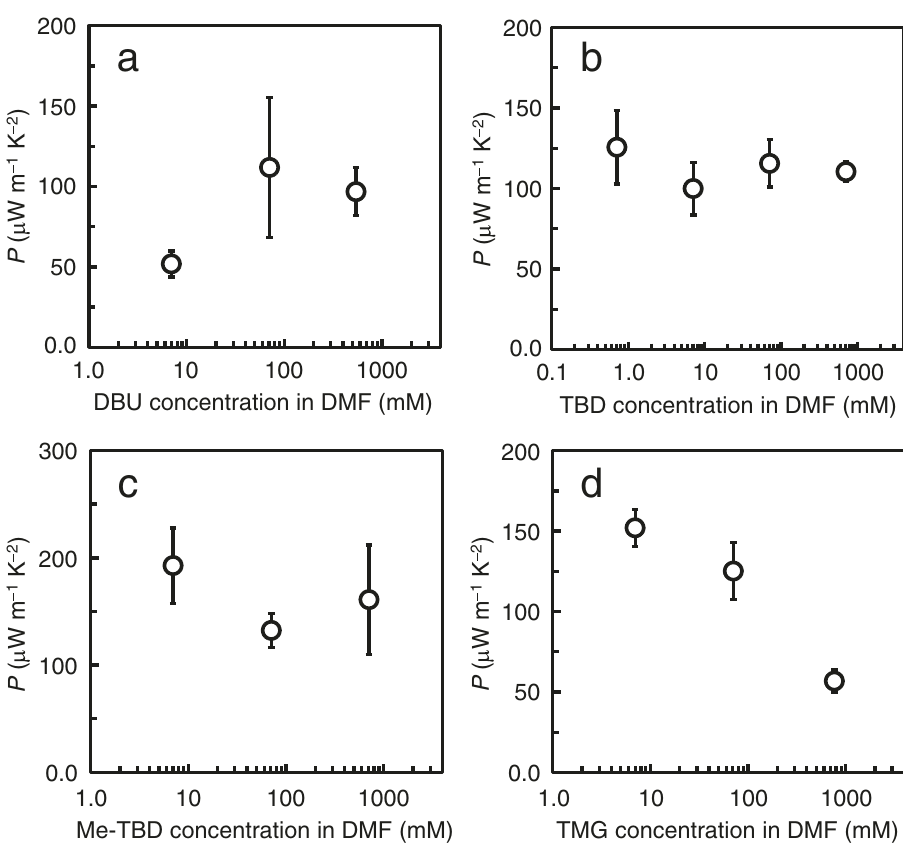
Fig. 7 Dopant-concentration-dependent Power factor ( P ). n-Type specimens were prepared by immersing EC1.5-CNT fi lms in DMF solutions of a DBU, b TBD, c Me-TBD, d TMG with varied concentrations. Data statistics: n ≥ 3. Error bars indicate the corresponding SDs. The ideal variations of